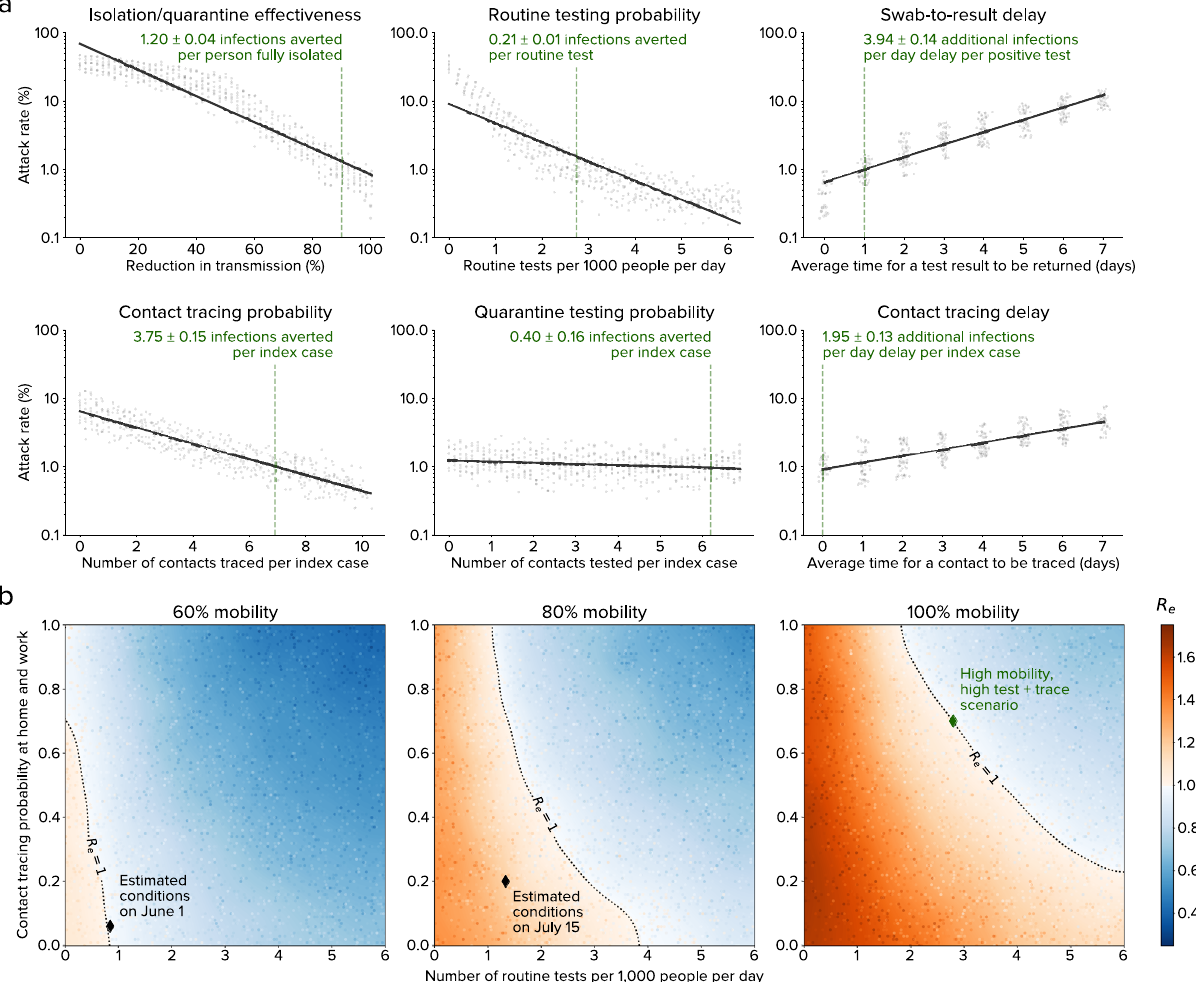
Fig. 4 Impact of testing, tracing, and quarantine. a Relative importance of different aspects of the TTQ strategy for a scenario of high mobility (full return to baseline workplace and community movement patterns), high testing, and high tracing in Seattle. Each dot shows a simulation, with other parameters held constant (at the values indicated by the dashed green lines). Low levels of isolation/quarantine effectiveness or routine testing probability lead to the highest attack rates, although all parameters have a signi fi cant impact on epidemic outcomes. b Countering the effects of increased mobility via testing, tracing, and quarantine. Current interventions (black diamonds) were estimated to keep R e < 1 for 60% of baseline mobility level (left). Subsequently, increased transmission rates exceeded intervention scale-up, temporarily leading to R e > 1 (center). For a return to full mobility (right), high levels of both testing and tracing are required to maintain epidemic control (green diamond, corresponding to the dashed lines in panel a ). Dots show individual